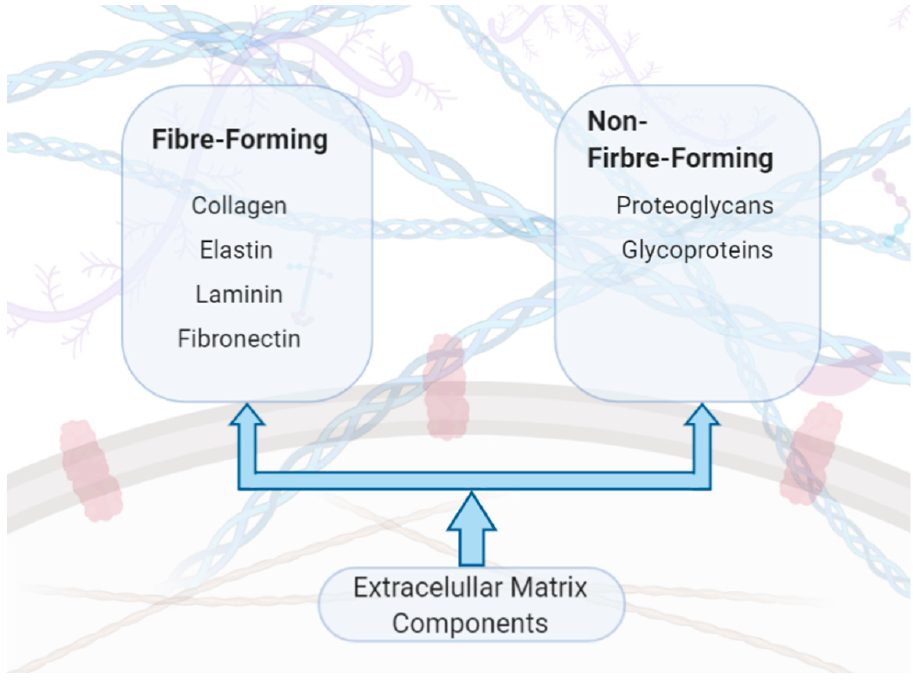
Figure 1. Components of the extracellular matrix (ECM).